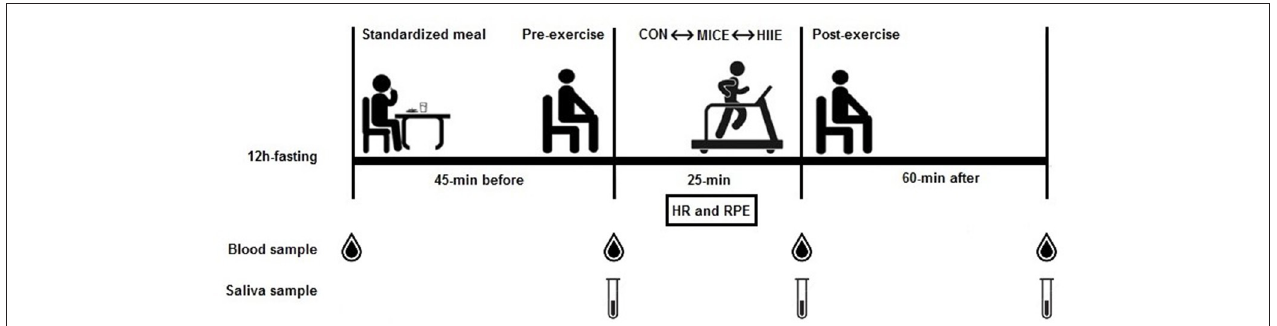
FIGURE 1 | Summary of experimental design. Standardized meal after 12h fasting; 45-min resting before exercise; 25-min exercise session (control, MICE, and HIIE); 60-min recovery; HR, heart rate; RPE, rating of perceived exertion.